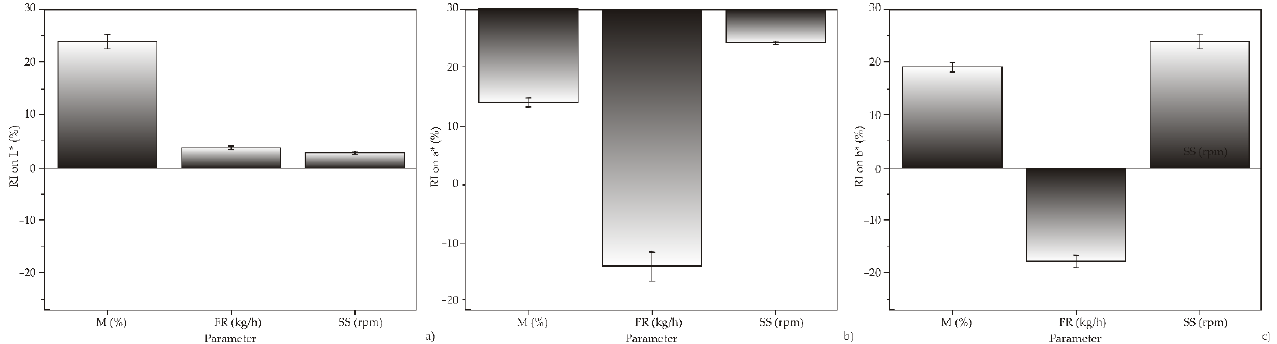
Figure 4. The relative importance of the extrusion parameters on the color parameters ( a ) L*—lightness; ( b ) a*—red/green color; ( c ) b*—yellow/blue color, using Yoon’s interpretation method.